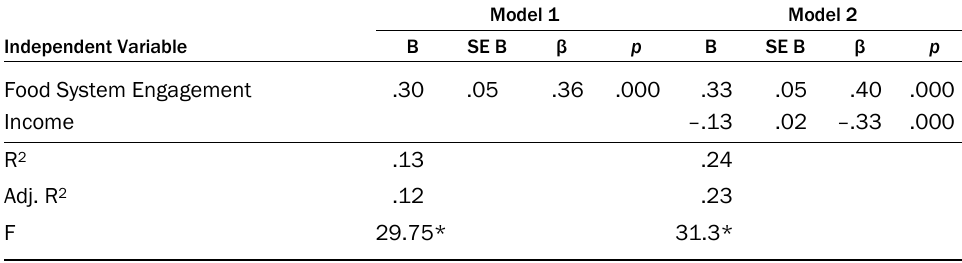
Table A2. Dependent Variable: Intrinsic Satisfaction From Community Food